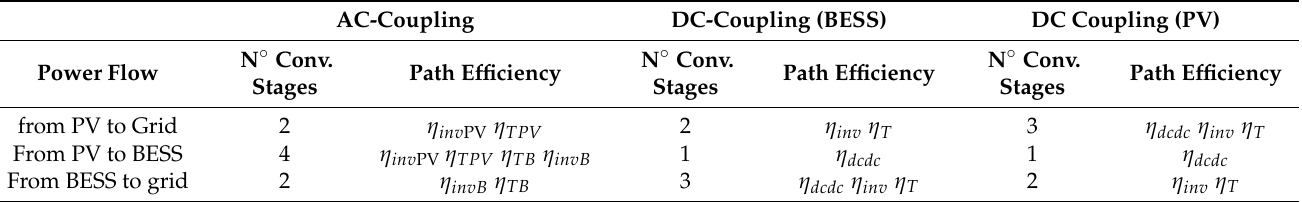
Table 2. Power efficiency and conversion stages based on power flow directions, where η inv PV and η invB are the efficiencies of the PV and BESS inverter, η TPV and η TB are the efficiencies of the PV and BESS transformers for the AC coupling layout. On the other hand, η inv is the inverter efficiency, η dcdc is the dc–dc converter efficiency and η T is the transformer efficiency for both DC-coupling